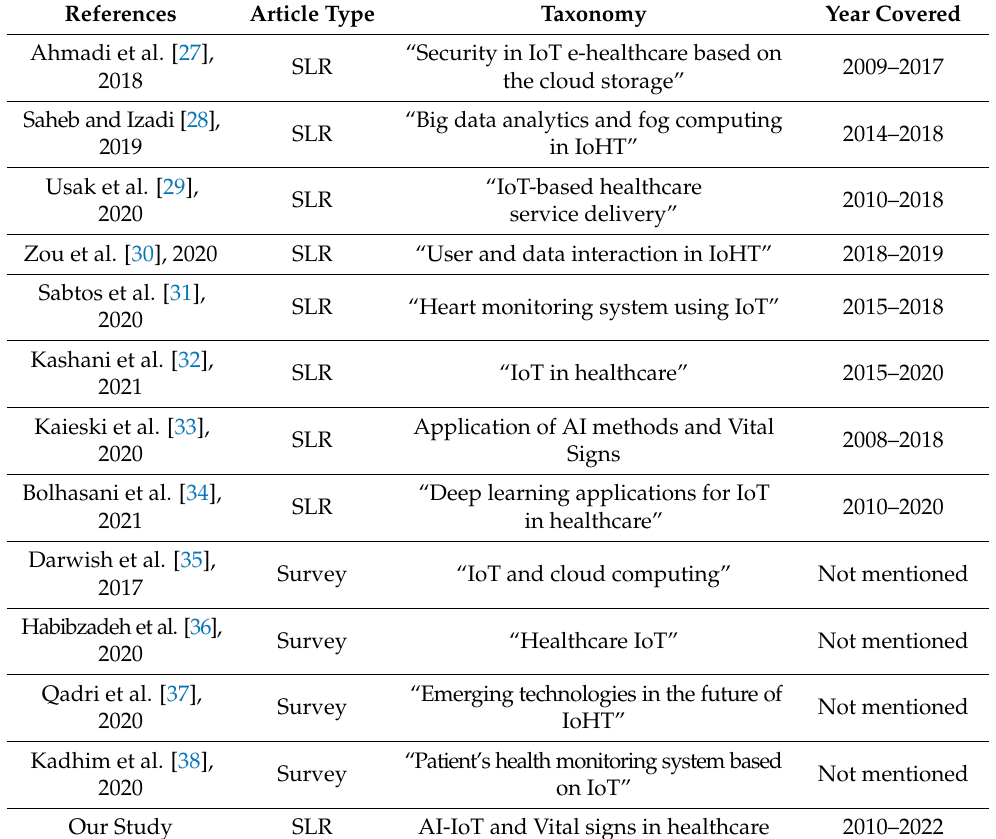
Table 1. Summary of related literature on AI/ML applicable to IoHT and vital health